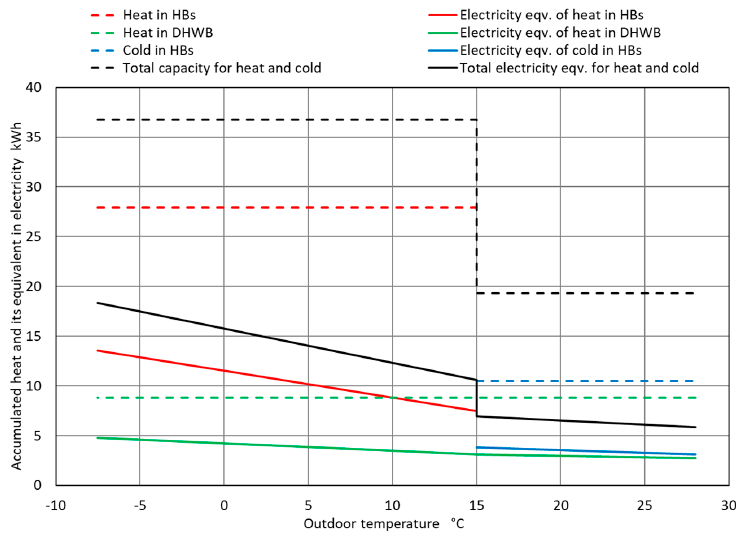
Figure 6. Possibilities of energy accumulation in the HBs and the DHWB.